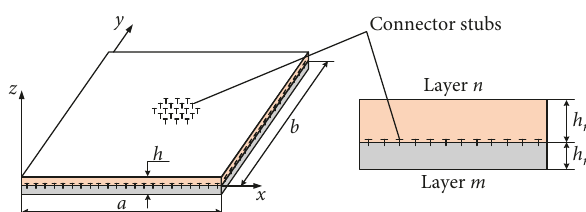
Figure 1: Geometrical notation of the two-layer